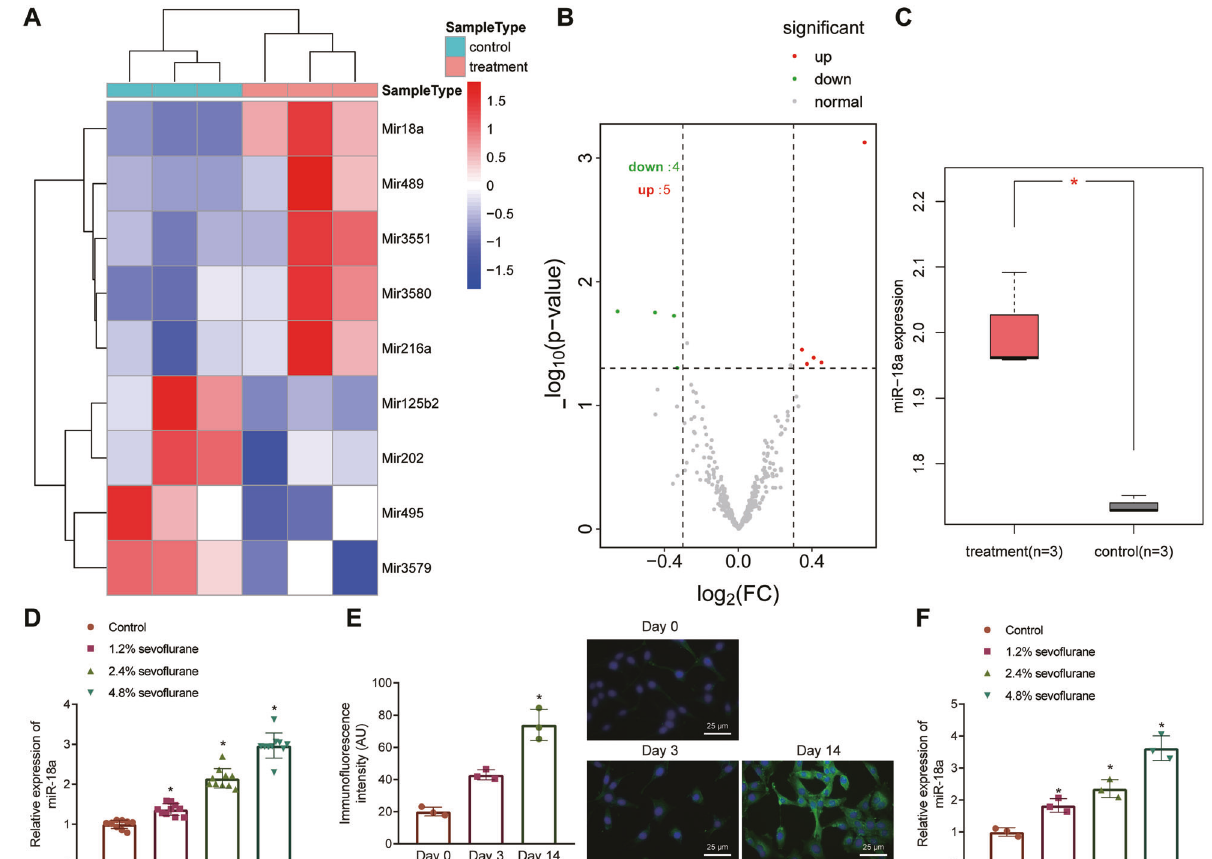
Fig. 1 Sevo fl urane treatment increases miR-18a expression in rat hippocampal tissues and NSCs. A Heat map of differentially expressed miRNAs in the microarray GSE141242 (control: n = 3; treatment: n = 3). B Volcano map of differentially expressed miRNAs in the microarray GSE141242. C Box plot showing the expression of miR-18a, wherein red indicates the sevo fl urane treatment group ( n = 3), gray indicates control group ( n = 3) (* p < 0.05 vs. the control group). D, RT-qPCR detection of miR-18a expression in rat hippocampal tissues under different concentrations of sevo fl urane treatment, n = 6, * p < 0.05 vs. the control group. E, Morphology of NSCs isolated 0, 3 and 14 d after primary culture and nestin protein expression under fl uorescence microscope (* p < 0.05 vs. data at day 3) (bar = 25 μ m); DAPI: the nucleus in blue fl uorescence; nestin protein: green fl uorescence. F, RT-qPCR detection of miR-18a expression in NSCs under different concentrations of sevo fl urane treatment, * p < 0.05 vs. the control group. The results were measurement data, expressed as mean ± standard deviation, and analyzed by independent sample t -test. The cell experiment was repeated 3 times